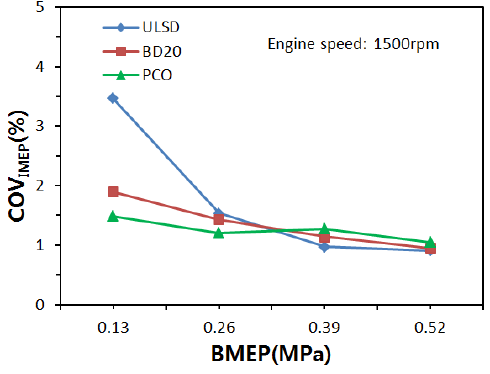
Figure 7. Effect of test fuels on COV IMEP according to BMEP.